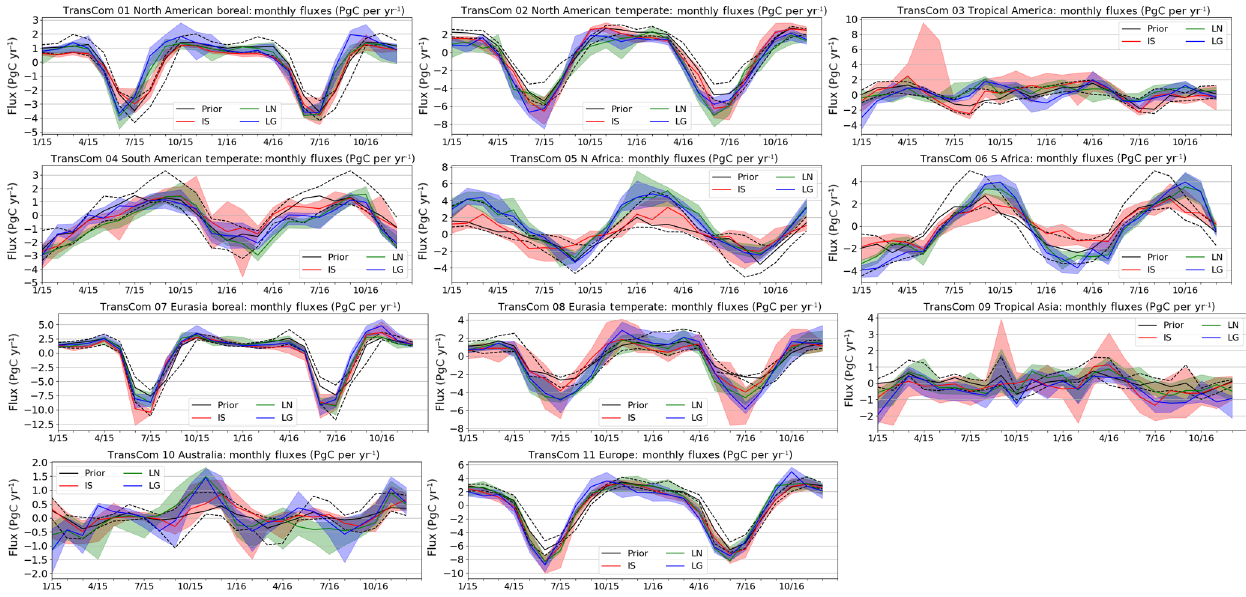
Figure B3. As in Fig. B1, except that the fluxes are by month.